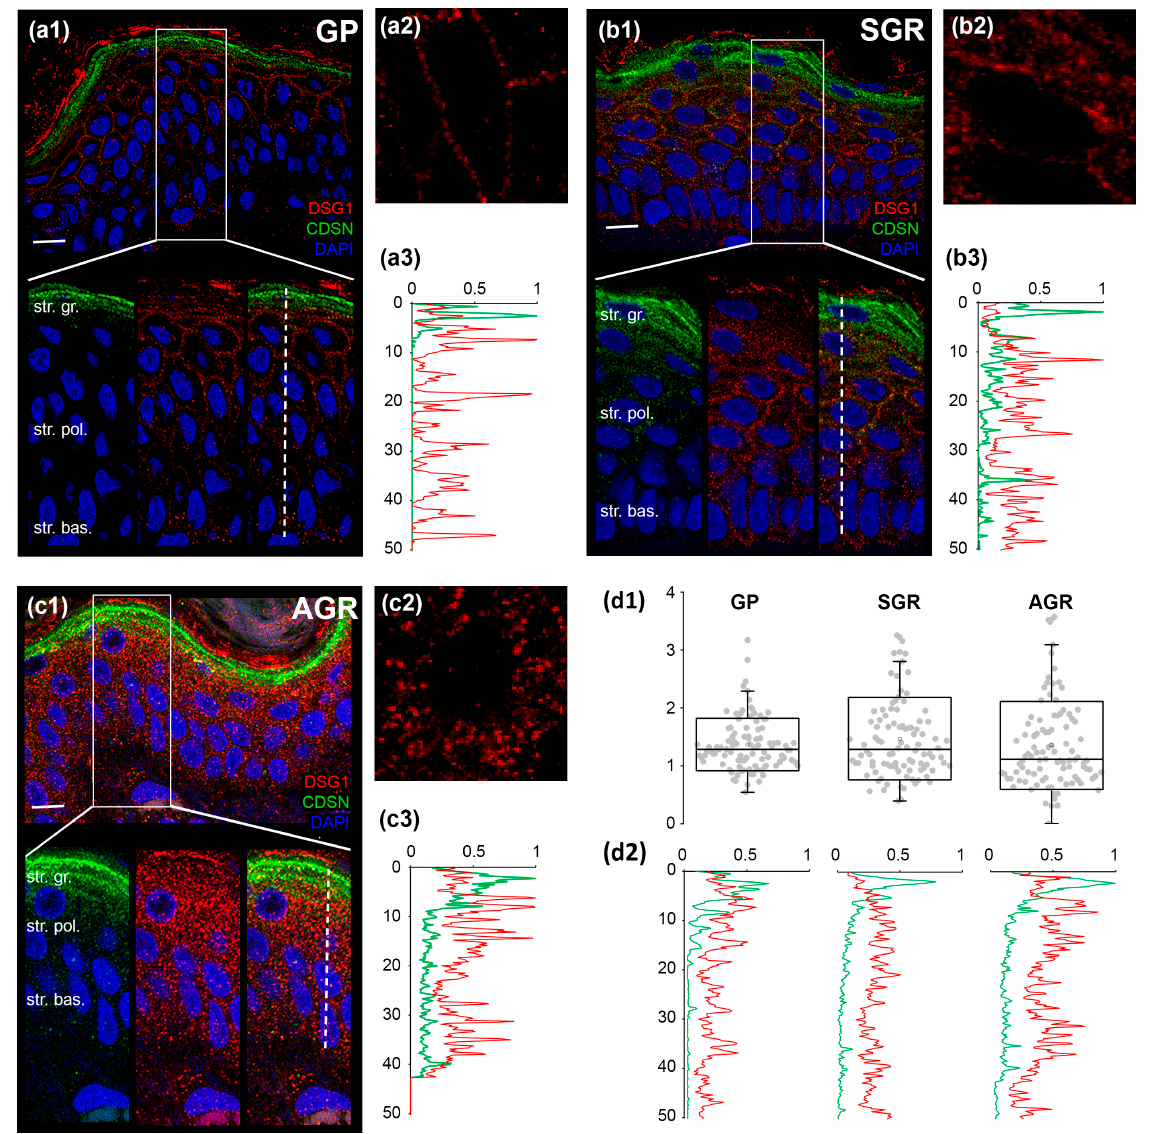
Figure 3. Less organized (corneo)desmosomes characterize SGR and AGR regions compared to GP skin areas. Double immunofluorescent staining against DSG1 (red) and CDSN (green) was performed to visualize their expression in the epidermis of dry (GP; ( a1 )), sebaceous (SGR; ( b1 )), and moist (AGR; ( c1 )) skin types. Nuclei were stained with DAPI (blue). Strong expression of CDSN was apparent in the stratum granulosum of the epidermis of all skin regions. In SGR and AGR areas, a prominent widening of the CDSN expression towards stratum spinosum was observed, as indicated by the elevated line of the individual ( b3 , c3 ) and normalized green curves in ( d2 ). DSG1 staining was observed in deeper layers of the epidermis in SGR and AGR types (compare individual red curves in ( a3 , b3 , c3 ) and the normalized red curves in ( d2 ). DSG1 dots were more regularly spaced around keratinocytes of the GP epidermis ( a2 ), whereas the DSG1 dots were bunched up and irregularly distributed in SGR type ( b2 ) and, even more, in AGR type ( c2 ) skins. This difference in the regularity was indicated by the smaller dispersion of data points in the GP skin region compared with the SGR and AGR areas in d1. Each dot represents the distance between two adjacent tight junction structures around keratinocytes. Scale bar on all images: 10 μ m. The Y -axis indicates the distance in micrometers in ( a3 , b3 , c3 , d1 , d2 ). The X -axis in ( a3 , b3 , c3 , d2 ) shows the normalized intensity of the immunostaining.